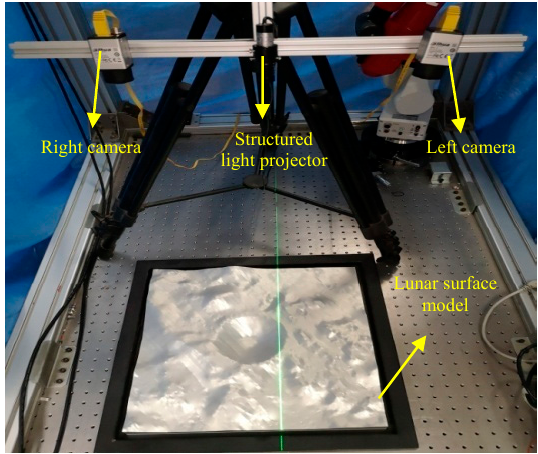
Figure 7. The schematic diagram of the experimental device.